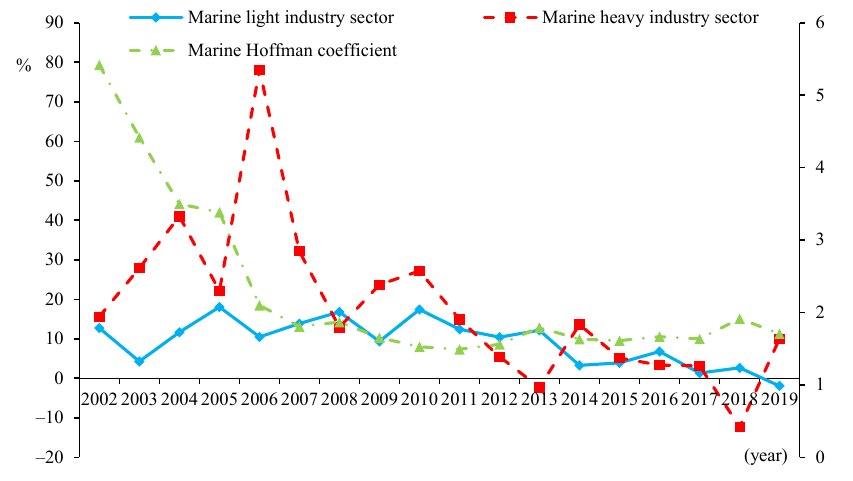
Figure 17. The growth rate of China ’ s marine industry sector and its Hoffman coefficient from 2002 to